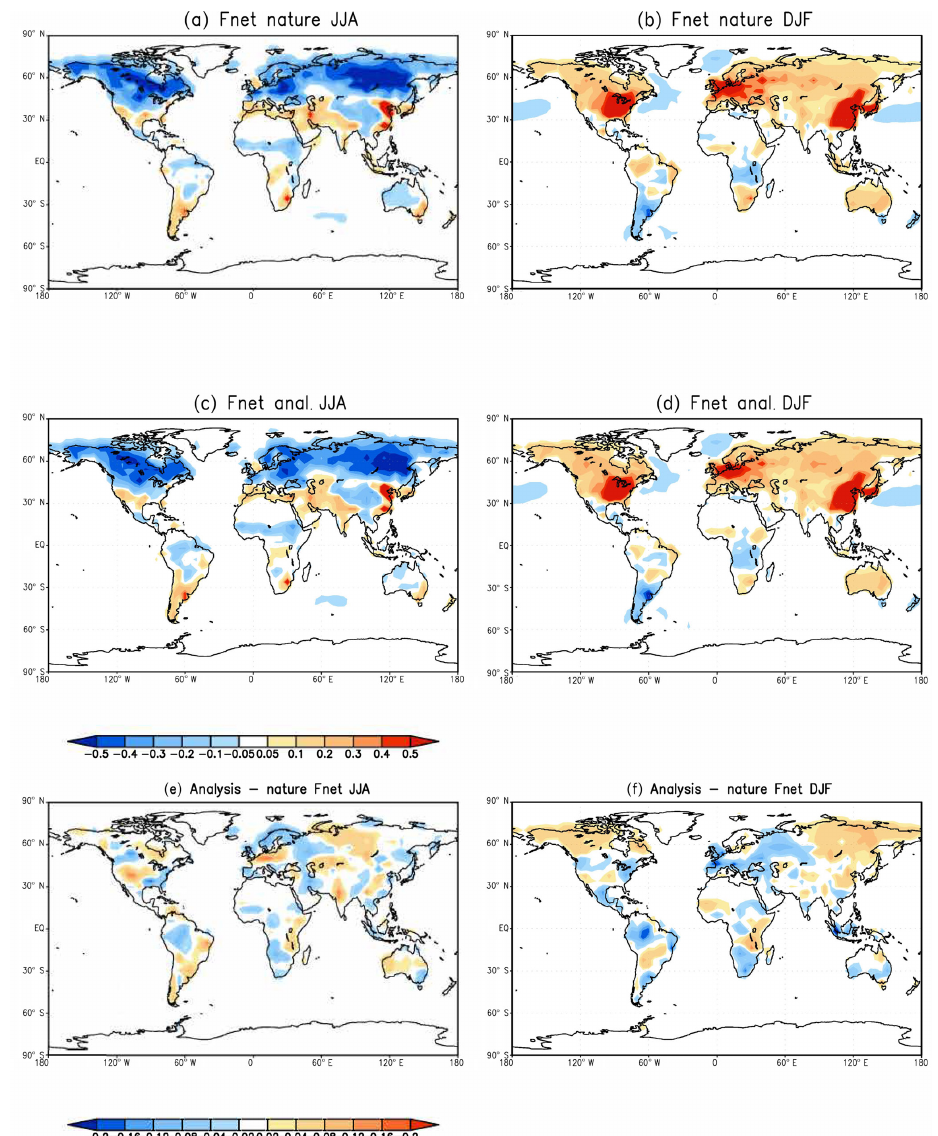
Figure 6. The SCF of the “nature” run and an estimation from the benchmark experiment (AW = 1d, OW = 8d) for Northern Hemisphere summer ( a , c and e ), and winter ( b , d , and f ). Panels (a) and (b) are the “truth” from the nature run, panels (c) and (d) are the estimates from benchmark experiment, and panels (e) and (f) are the difference between estimation and